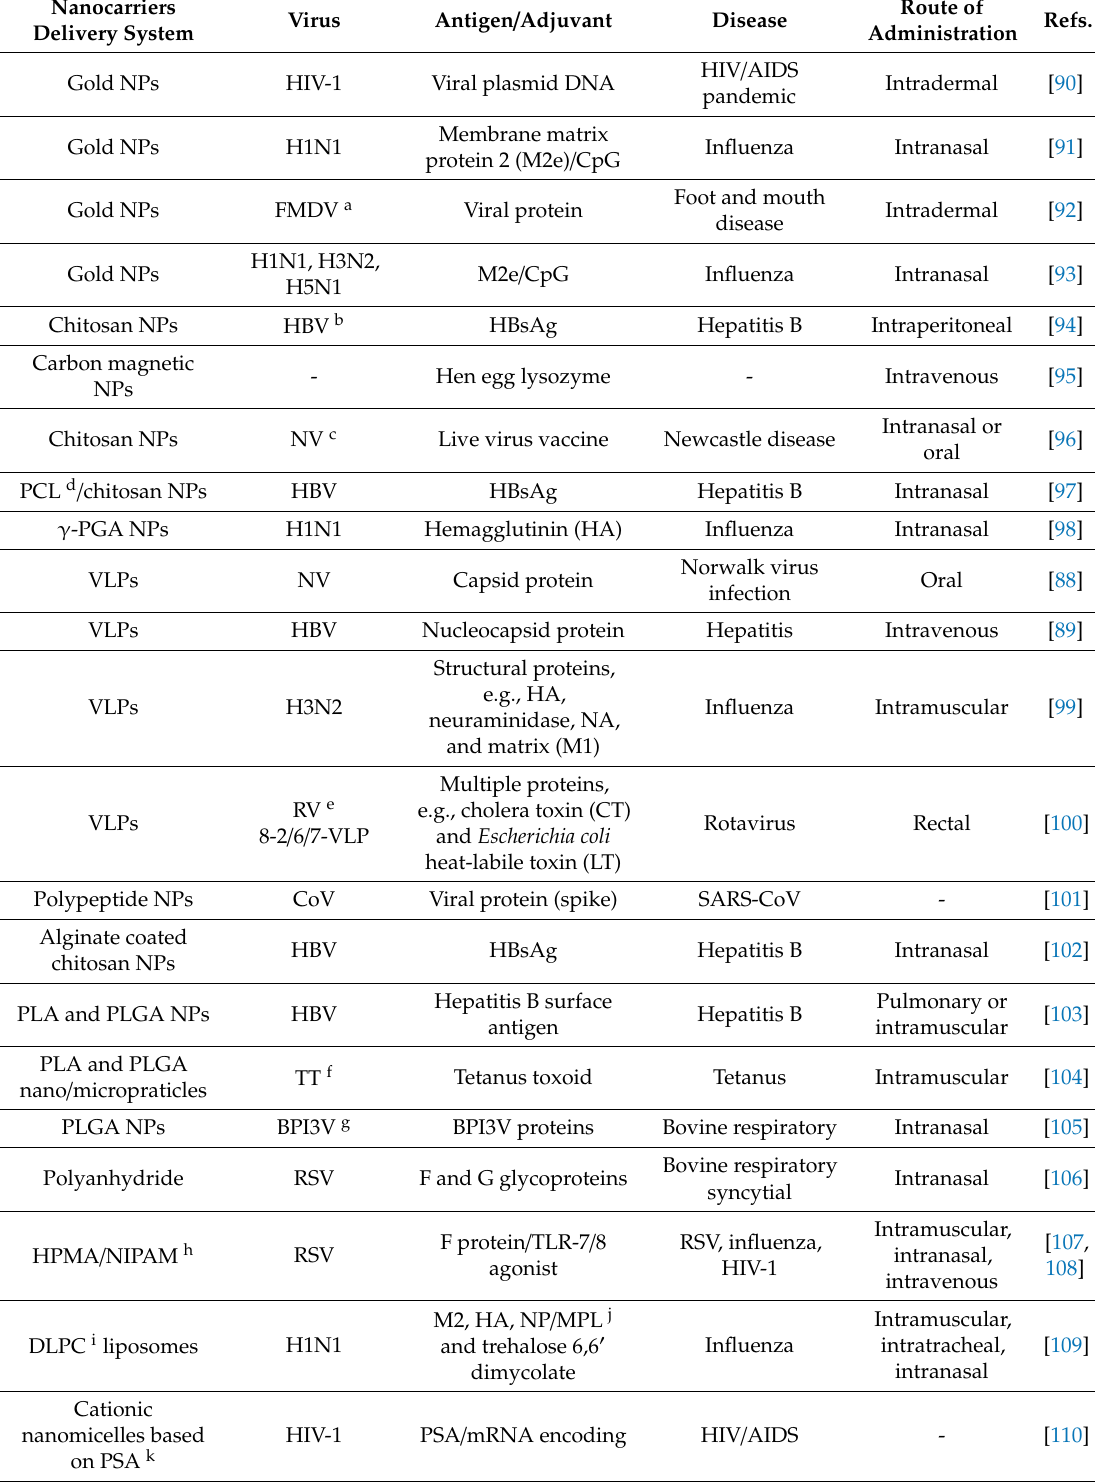
Table 5. Summary of diverse types of nanocarrier / NP-based vaccine delivery systems against viral